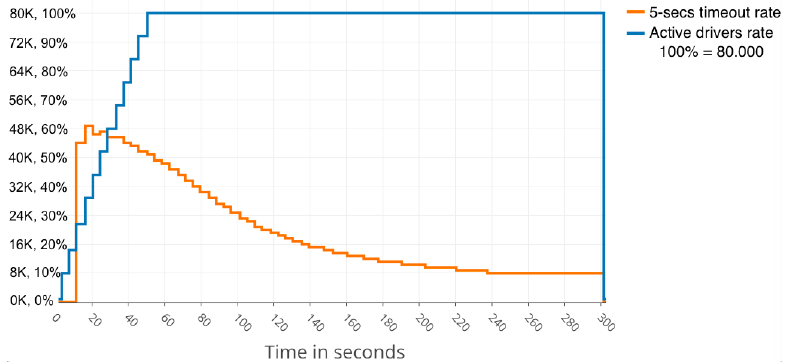
Figure 7. Partial recover after rising above 60% slow responses rate with a 62 KB message size and